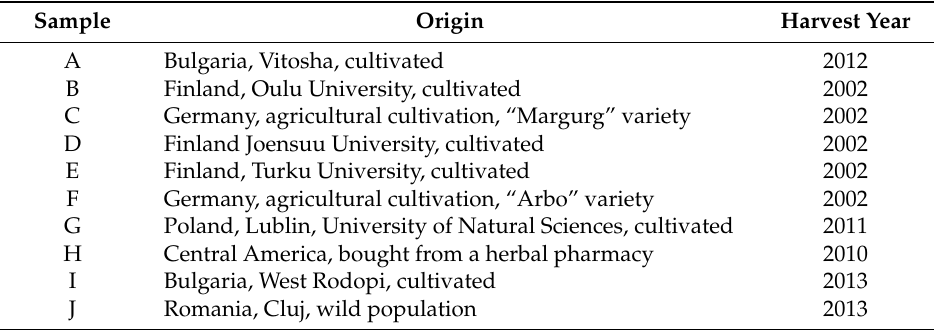
Table 1. Investigated samples